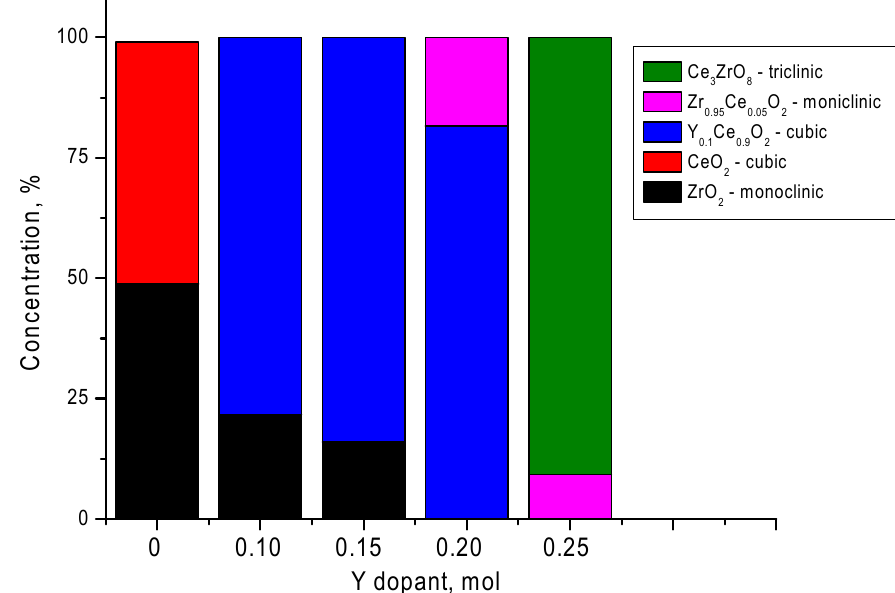
Figure 3. Diagram of the phase composition of ZrO 2 —CeO 2 ceramics, depending on the yttrium dopant concentration.